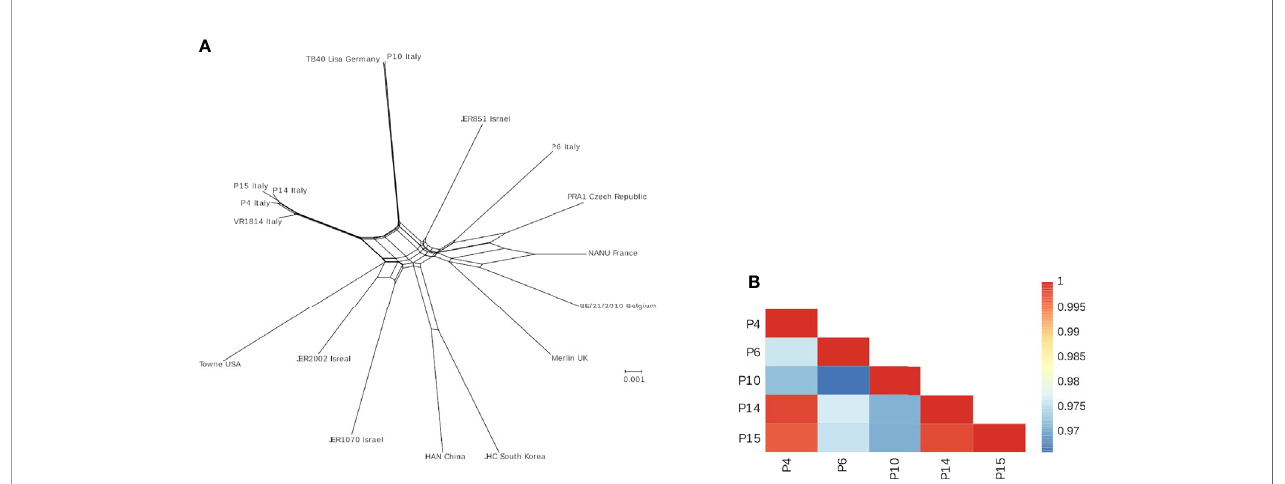
FIGURE 3 | (A) Neighbor-net split network of the fi ve HCMV isolates plus additional genomes sequences. The geographic location where each sample was isolated is indicated. (B) Color-coded pairwise identity matrix for the fi ve isolates. Each cell represents the percentage identity score between two sequences (indicated horizontally and vertically). The legend indicates the correspondence between pairwise identities and the color code. Identity scores were computed over all positions where gaps are not observed in either sequence.